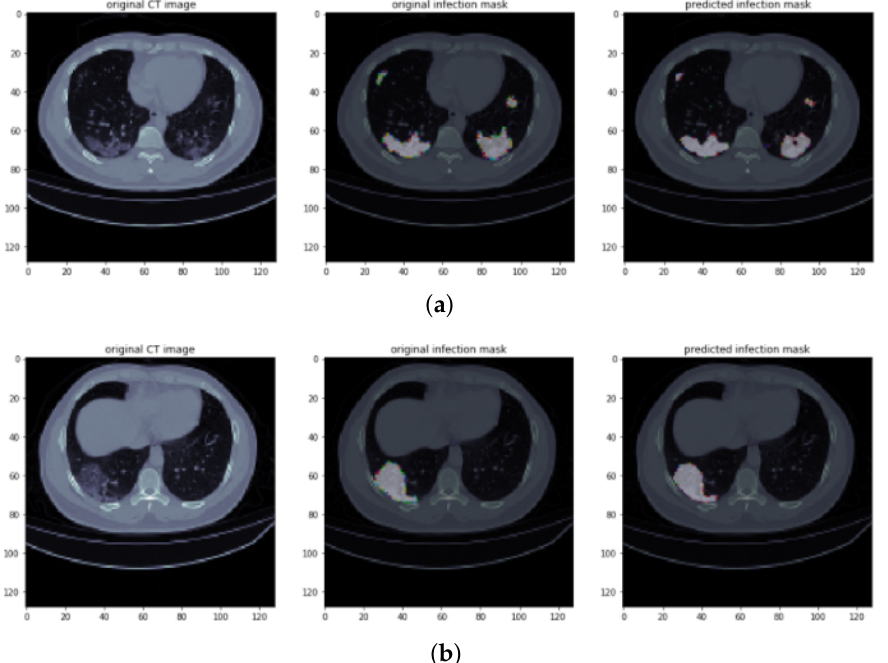
Figure 7. Infection segmentation results of CT scans: the sample images ( a , b ) show the progressive stage of viral infection. It can be seen that both lungs are affected from the virus and that infection is growing at different locations of lungs. Columns 1–3 show an original CT scan image, an original infection mask, and a predicted infection mask,